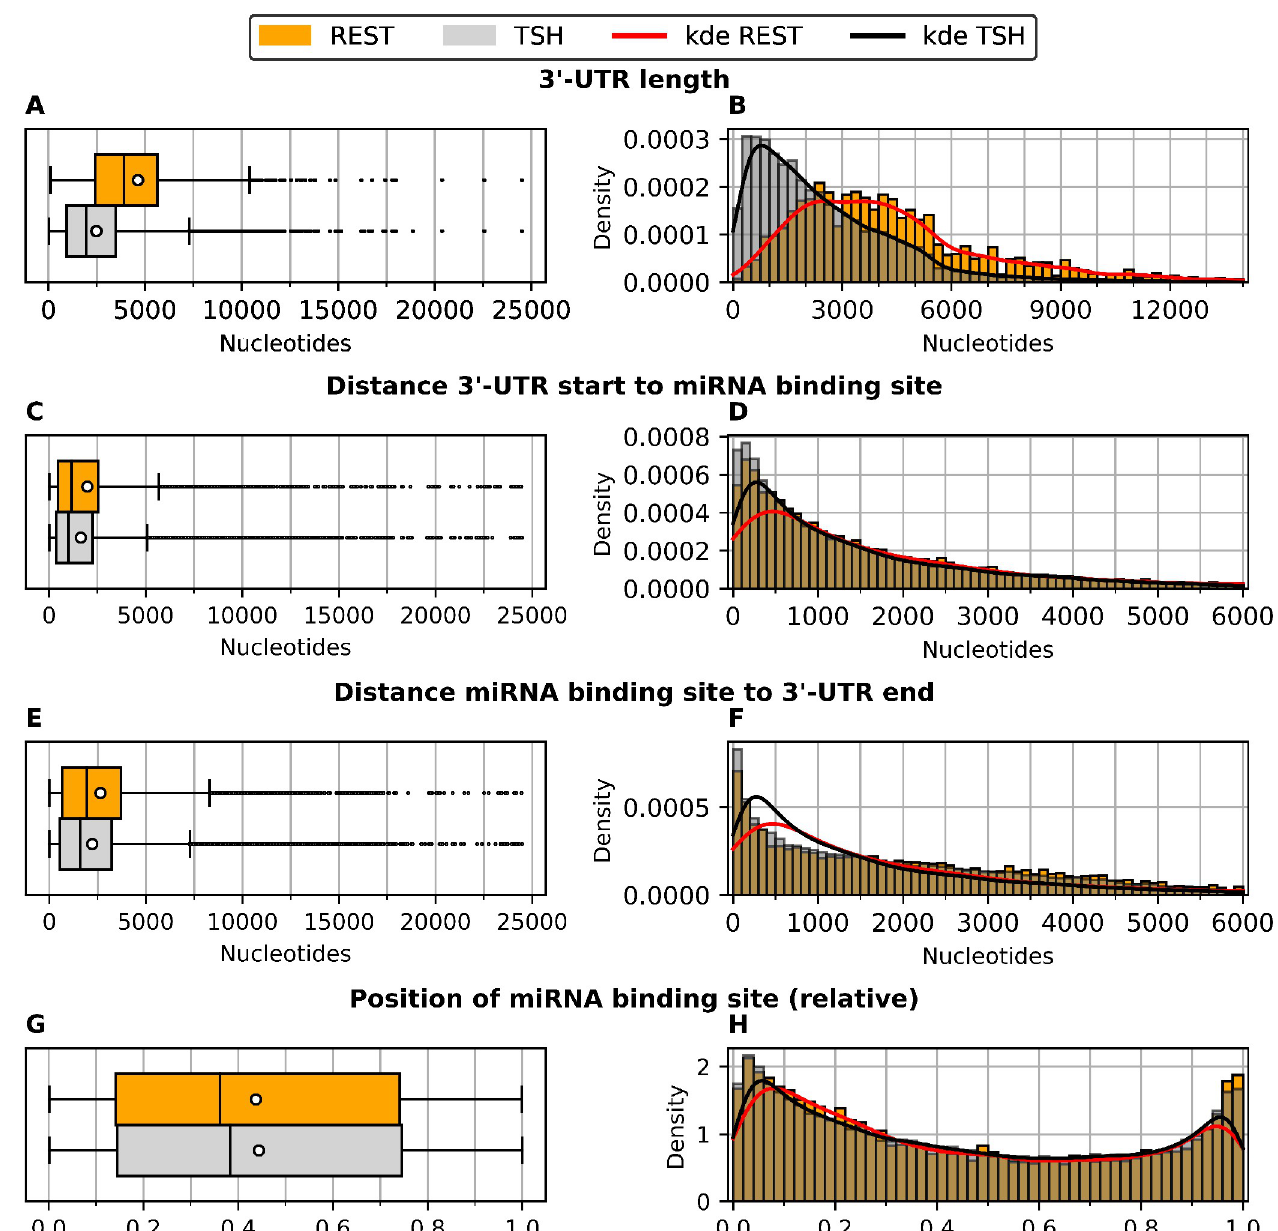
Fig 1. Properties of REST-associated miRNA-target gene pairs (REST) and TargetScanHuman miRNA-target gene pairs (TSH) or TargetScanHuman miRNA-target gene pairs in REST 3’-UTRs (TSH-REST). (A, B) Distribution of 3’-UTR length. (C, D) Distance from 3’-UTR start to miRNA binding site. (E, F) Distance from miRNA binding site to 3’-UTR end. (G, H) Relative position of miRNA binding site to the 3’-UTR length. Left side: the box plots indicate median, second and third quartile, mean (white dot) and standard deviation (whiskers). Right side: kde = kernel density of the corresponding